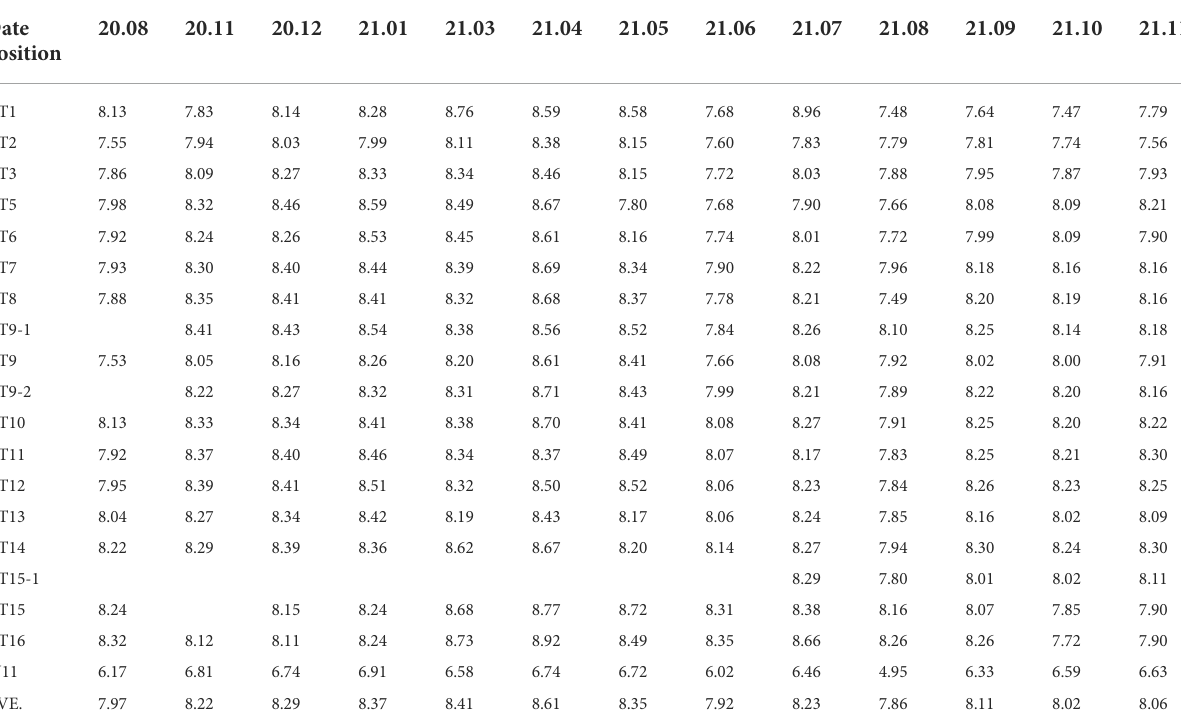
TABLE 1 pH data of river water in different months in the Huatan River